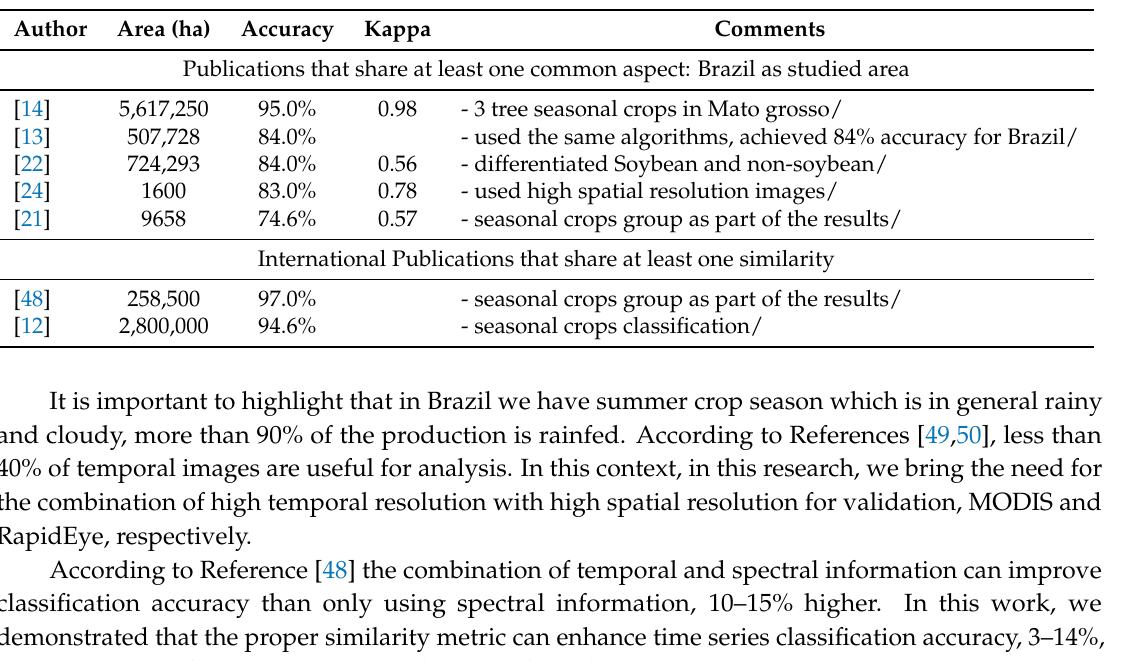
Table 6. Results